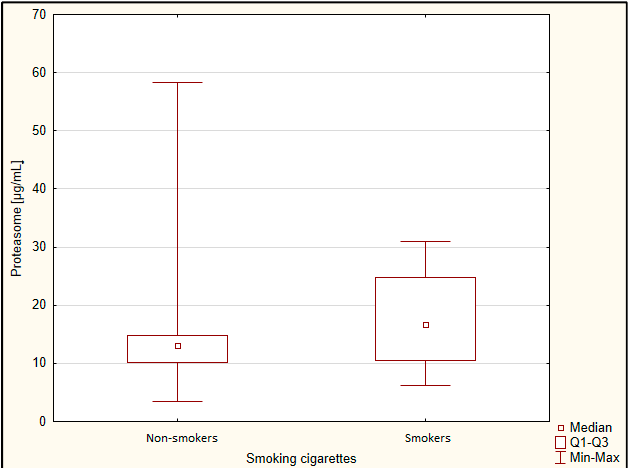
Figure 4. Concentration of proteasome depending on smoking cigarettes. Q1, lower quartile; Q3, upper quartile.